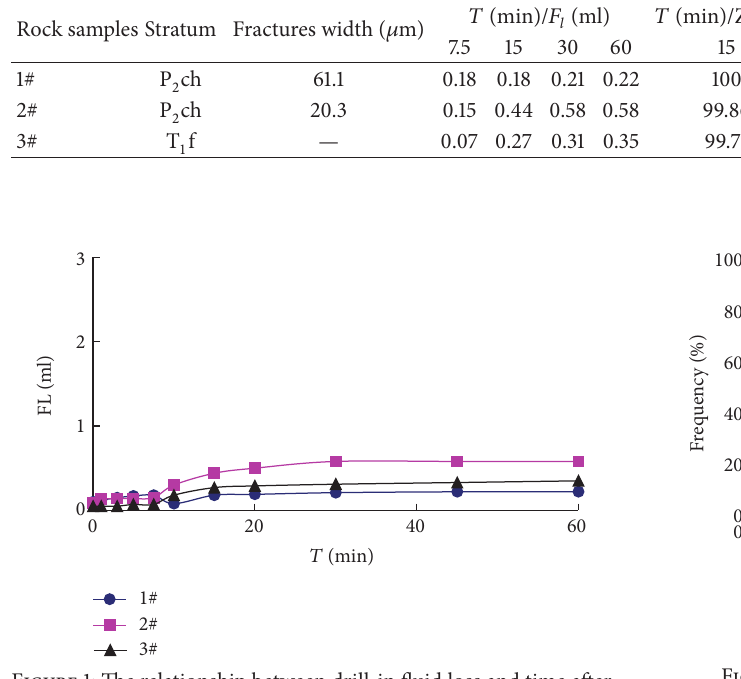
Figure 1: The relationship between drill-in fluid loss and time after the formation of shielding ring.